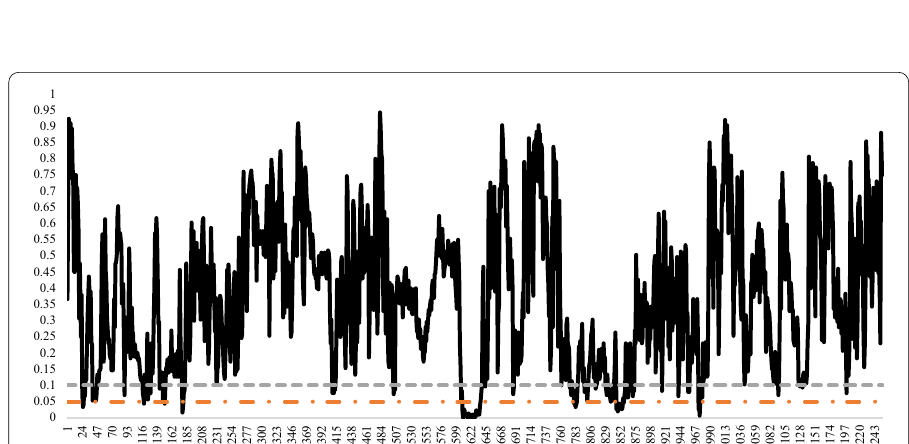
Fig. 27 The evolving p values of the GS test statistic checked for the Ripple (XRP) in 100-day window length